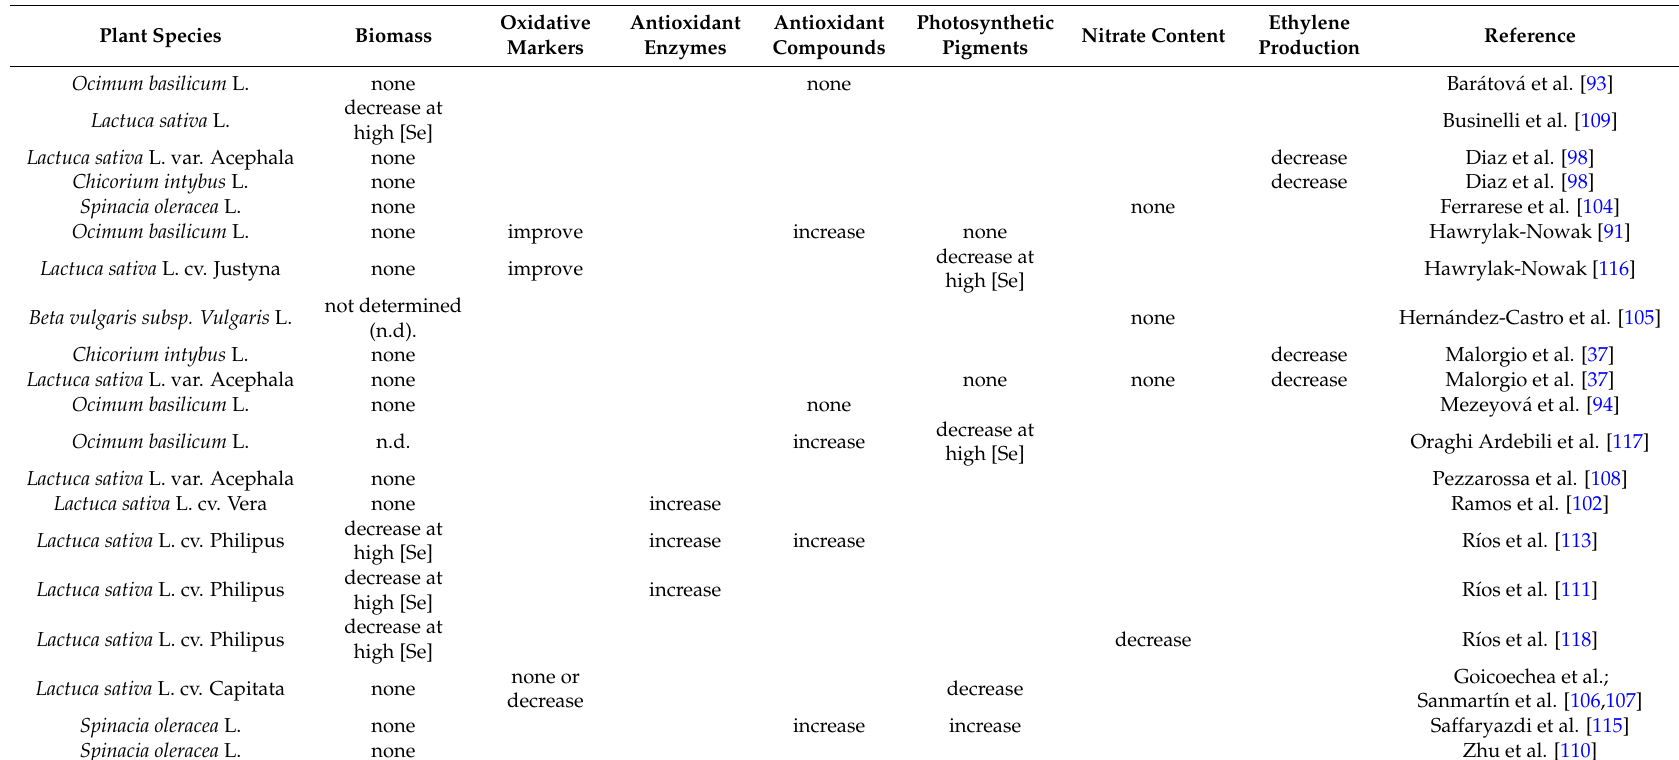
Table 2. Main effects of selenium (Se) treatments on leafy